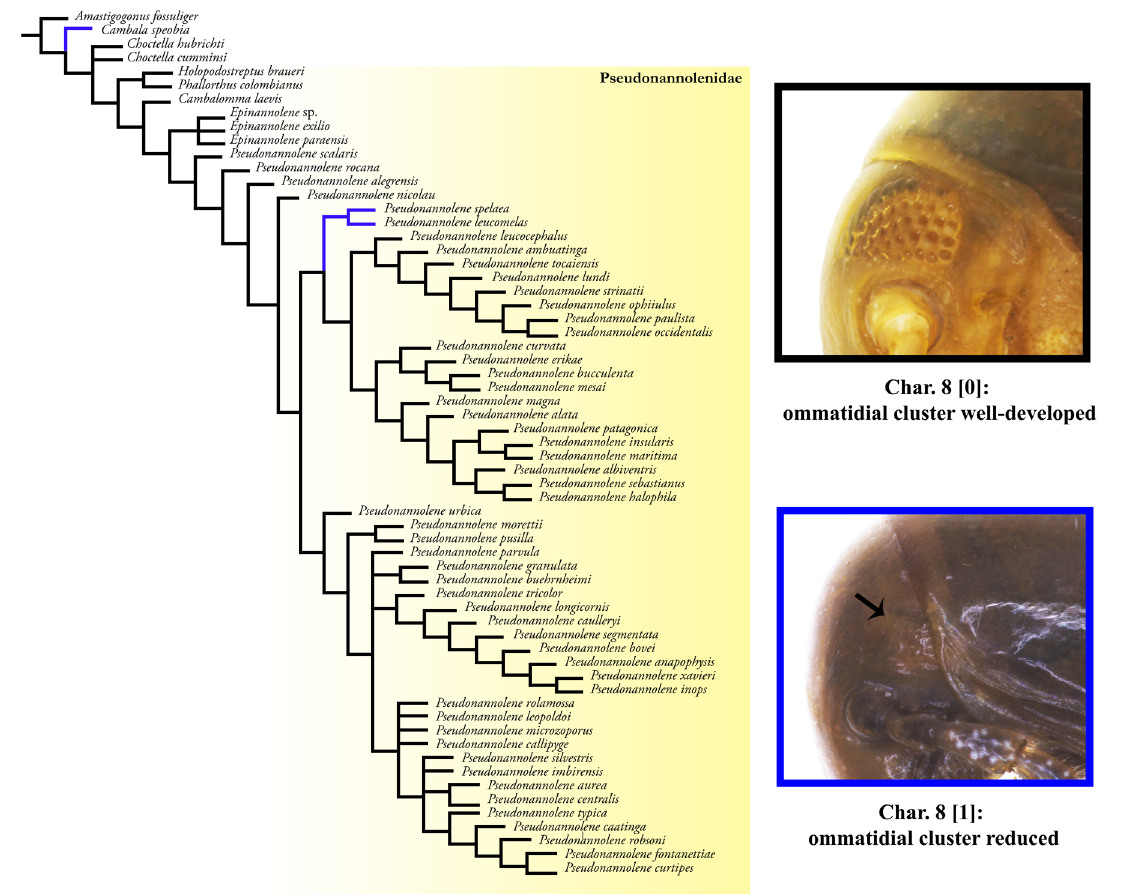
Fig. 12. Evolution of ommatidial cluster. Mapping on the strict consensus of 27 equally parsimonious trees under implied weighting ( k = 4–7). Images of ommatidial cluster: black = Pseudonannolene buhrnheimi Schubart, 1960 (IBSP 2397); blue = P. leucomelas Schubart, 1947 (MNRJ